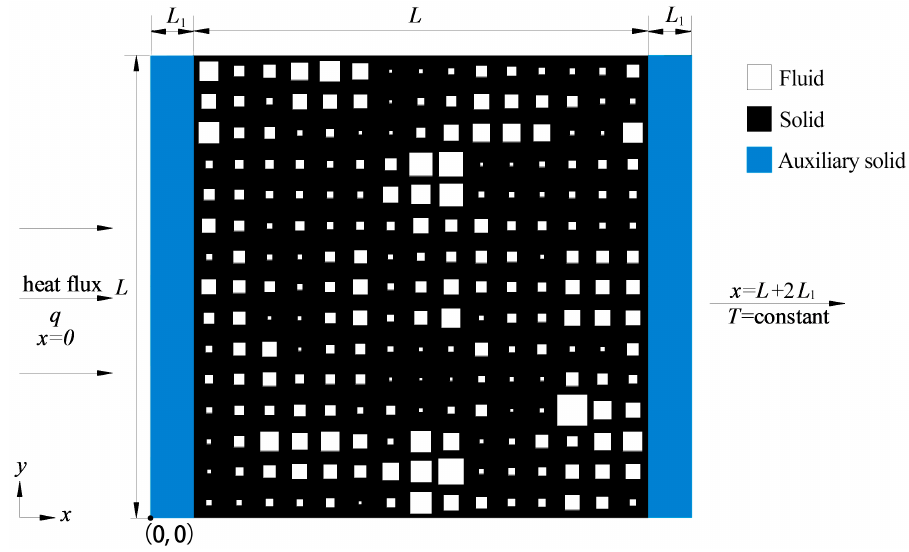
Figure 3. Schematic of heat conduction in the fractal porous material.